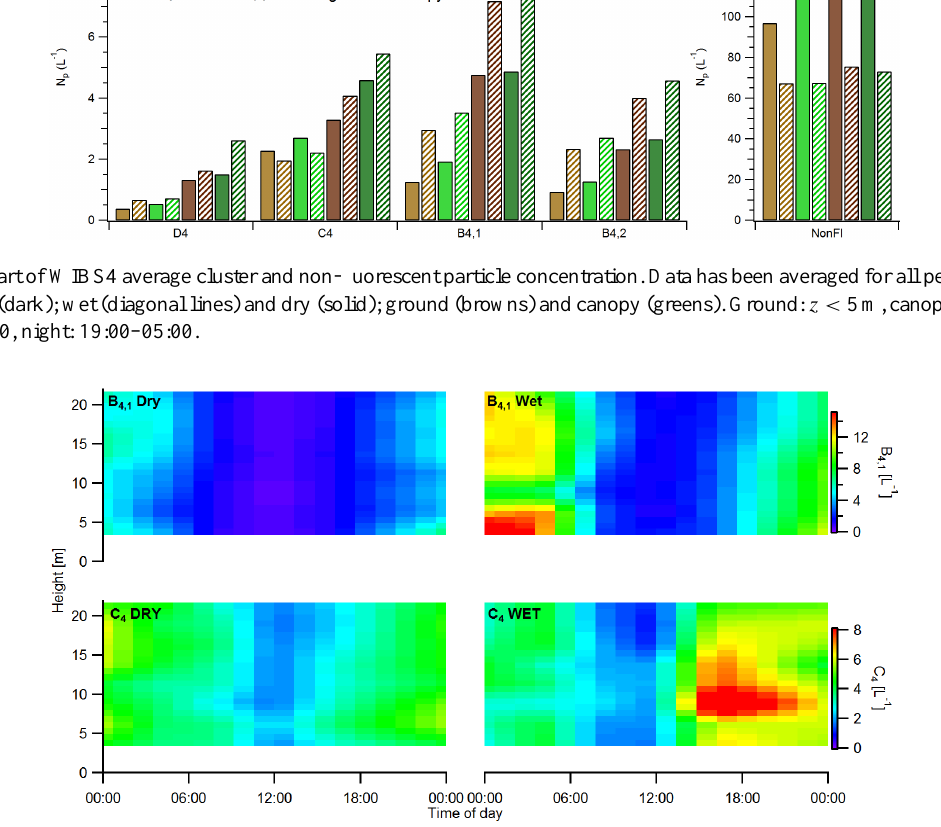
suggested rapid release of fungal spores when RH thresholds were reached in a tropical forest in Malaysia. Similarly, mul- tiple recent publications have suggested that diurnal patterns of fluorescent particle concentrations were regulated active emission of fungal spores due to the night time enhancement 810 of RH (e.g. Huffman et al. (2013); P¨oschl et al. (2010); Schu- macher et al. (2013); Toprak and Schnaiter (2013)). Basid- iomycota spores have also been identified at the MEFO site during measurements collected in parallel with the study re- ported here (Huffman et al., 2013; Prenni et al., 2013). As 815 such we suggest that cluster B 3 is likely representative of fungal spores.